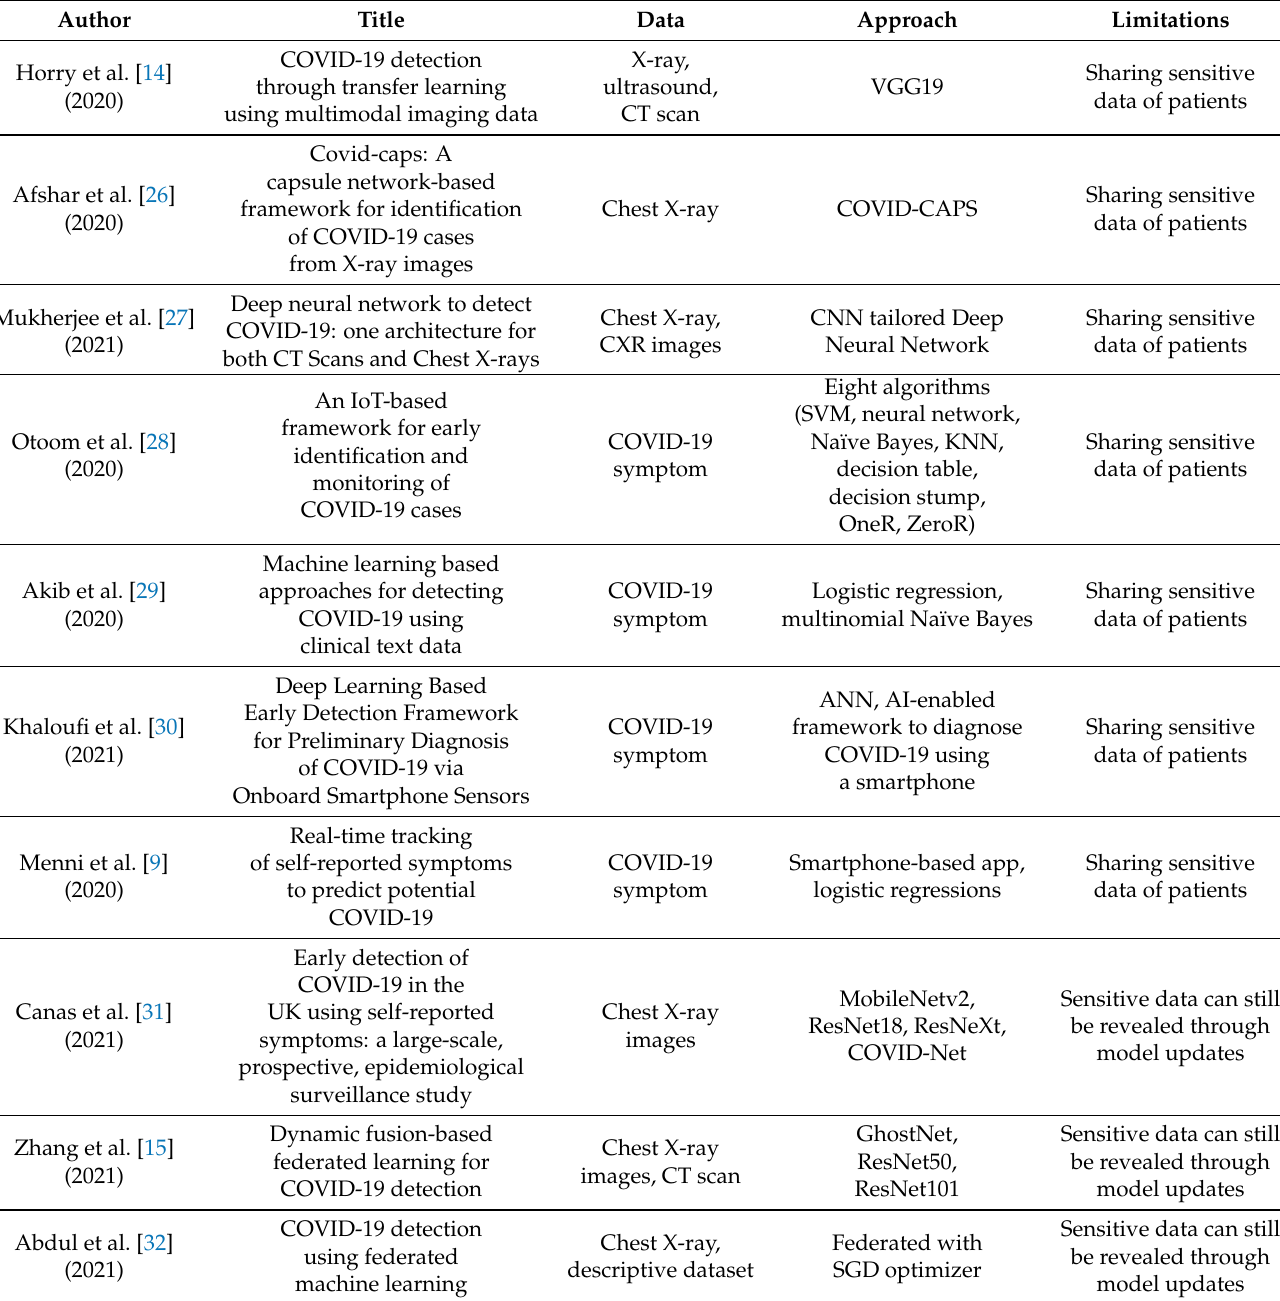
Table 1. The summary table of existing COVID-19 detection